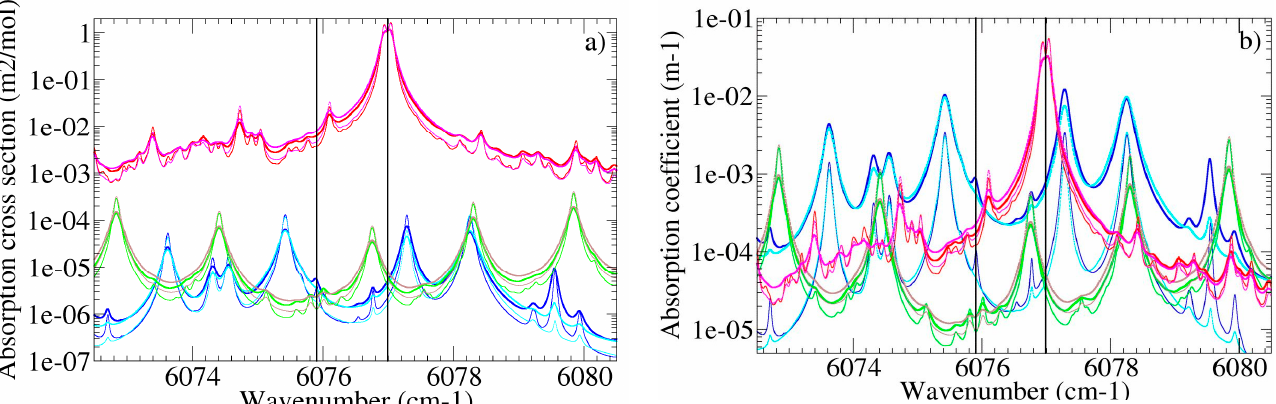
Figure 6. ( a ) The molar absorption cross sections (m 2 /mol) and ( b ) the molar absorption coefficient (m − 1 ) from 6072.5 cm − 1 to 6080.5 cm − 1 for methane/water vapour/carbon dioxide (respectively in red-magenta/blue-cyan/green-brown) and for four sets of pressure and temperature. The molar absorption coefficients are calculated with a concentration of 1780 ppb for CH 4 , 1% at P = 1013.25 hPa and 1‰ at P = 500 hPa for H 2 O and 400 ppm for CO 2 .The curves are bold red/blue/green for P = 1013.25 hPa and T = 300 K, bold magenta/cyan/brown for P = 1013.25 hPa and T = 250 K, thin red/blue/green for P = 500 hPa and T = 280 K and thin magenta/cyan/brown for P = 500 hPa and T = 220 K. The vertical black lines indicate the spectral position of the Off and On laser emissions.